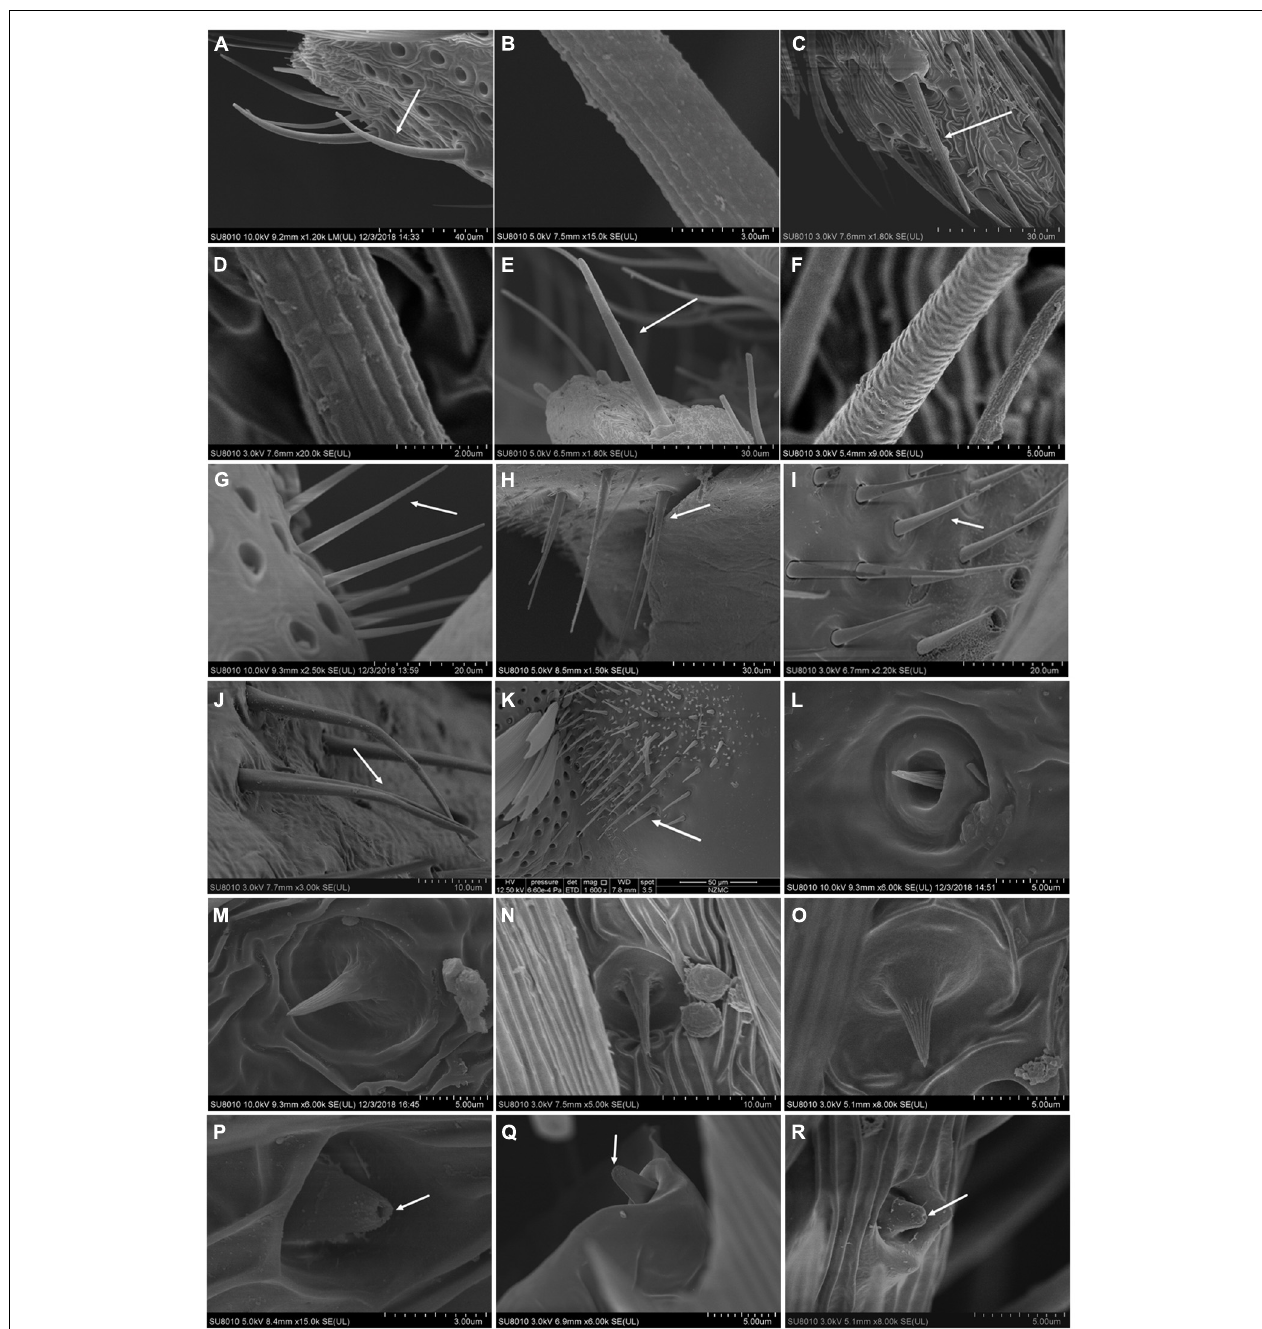
FIGURE 1 | Different types of sensilla in three species of Limacodidae by SEM. (A–F) Sensilla chaetica, (A,B) SCh I of N. flavidorsalis ; (C,D) SCh I of C. castaneipars ; (E,F) SCh II of S. postornata ; (G–K) Böhm’s bristles, (G) BB I of N. flavidorsalis , (H) BB II of N. flavidorsalis , (I) BB I of C. castaneipars , (J) BB I of S. postornata , (K) BB II of S. postornata ; (L–O) Sensilla coeloclnica, (L) SCo I of N. flavidorsalis , (M) SCo II of N. flavidorsalis , (N) SCo II of C. castaneipars ; (O) SCo II of S. postornata . (P–R) Sensilla uniporous peg, (P) N. flavidorsalis ; (Q) C. castaneipars ; (R) S. postornata . The arrow points to the hole at the tip of the